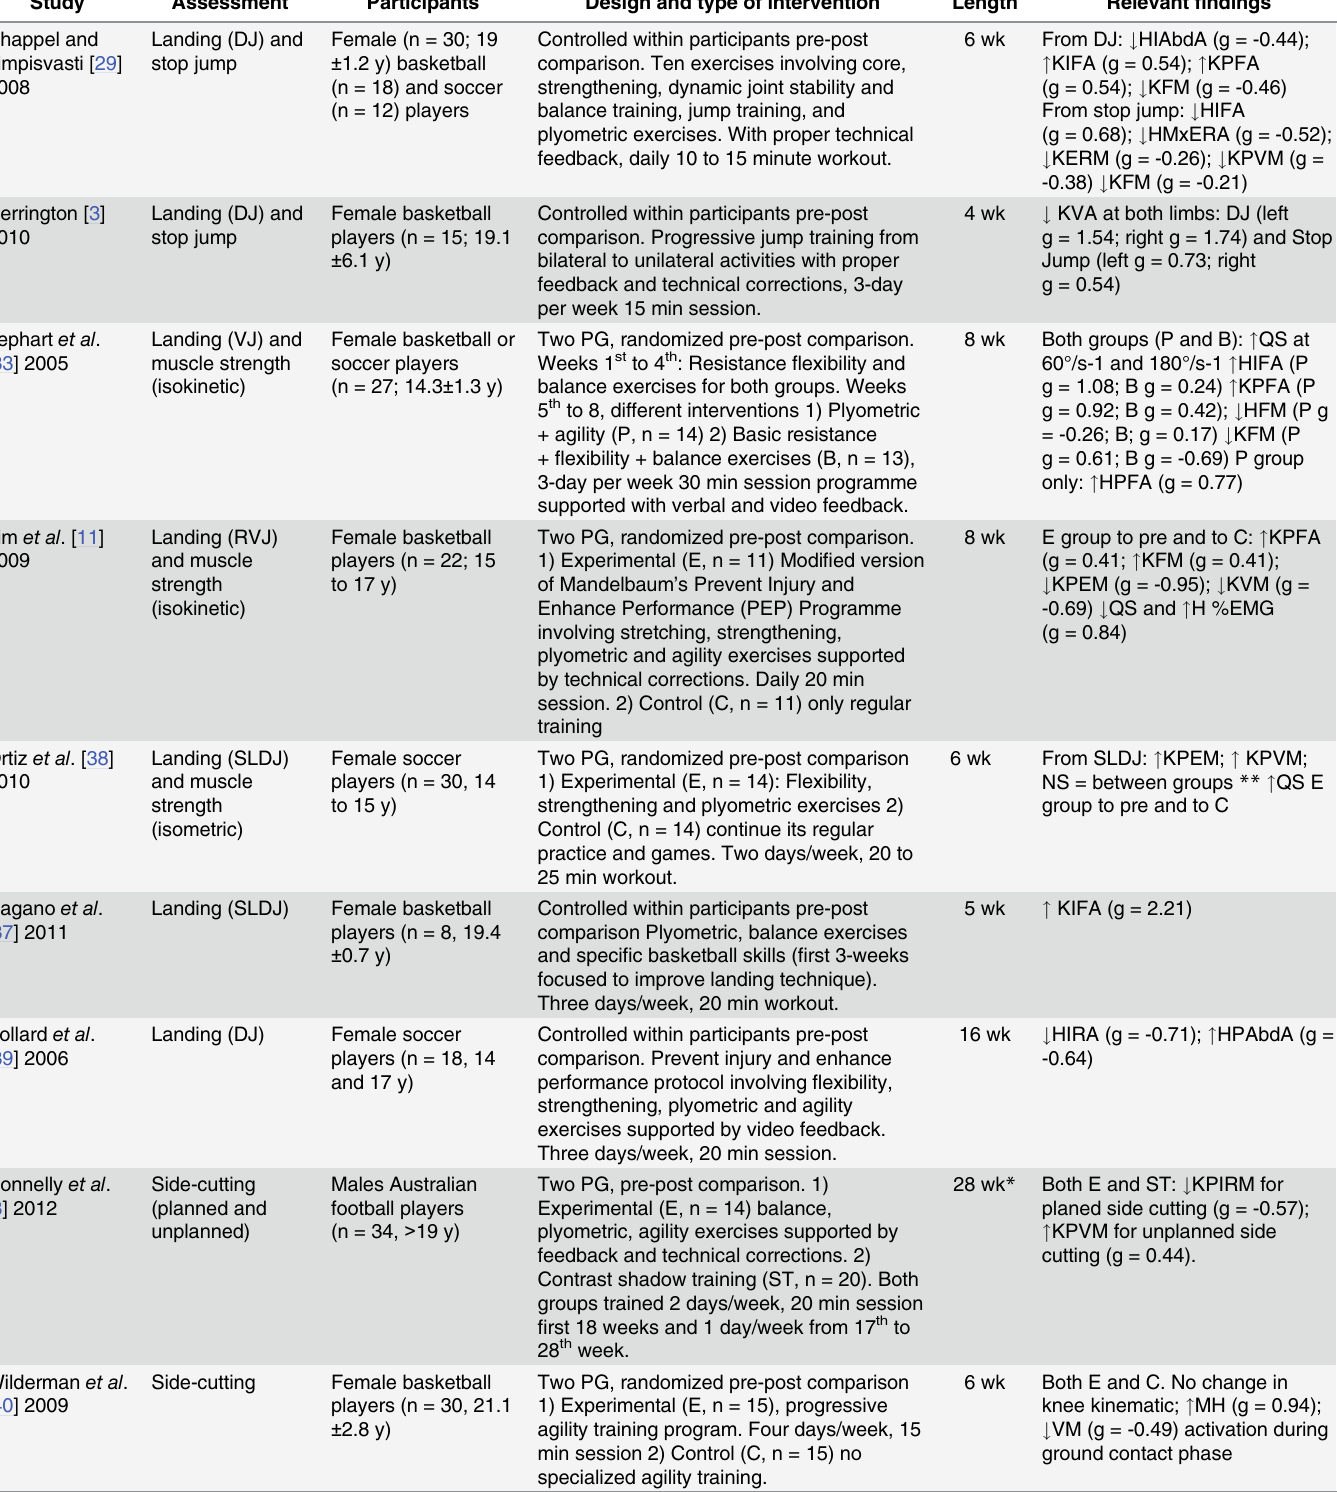
Table 3. Summary of the main characteristics and relevant finding of the 19included